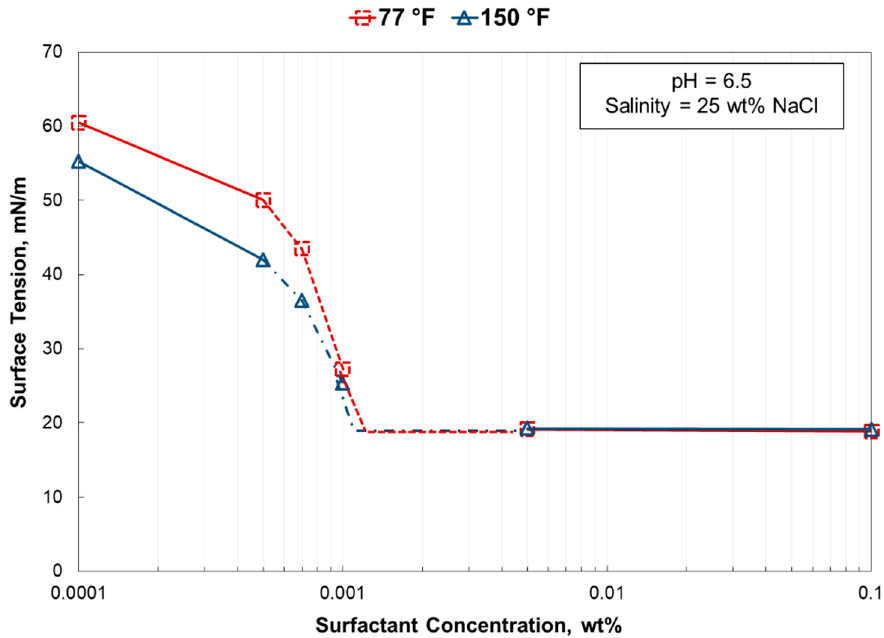
Figure 14. Effect of temperature on surfactant interfacial properties at pH 6.5 and 25 wt% NaCl.